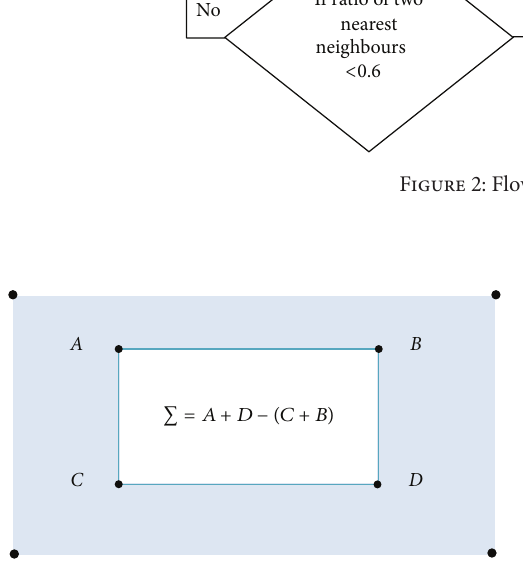
Figure 3: Integral image calculation by rectangular